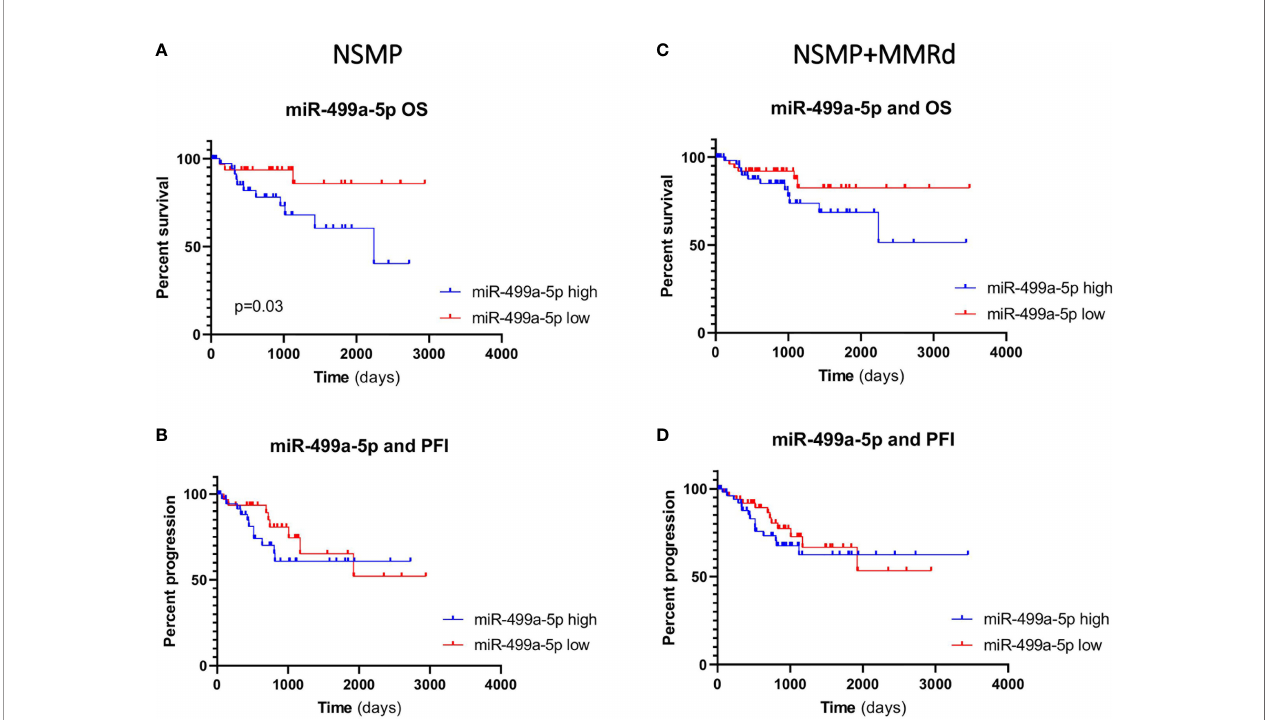
FIGURE 4 | Kaplan – Meier estimates of overall survival (A, C) and progression-free interval (B, D) in NSMP alone and NSMP + MMRd groups, based on miR-499a- 5p expression.